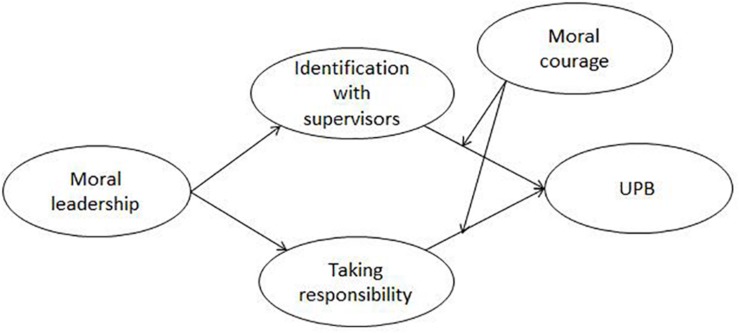
The research model.